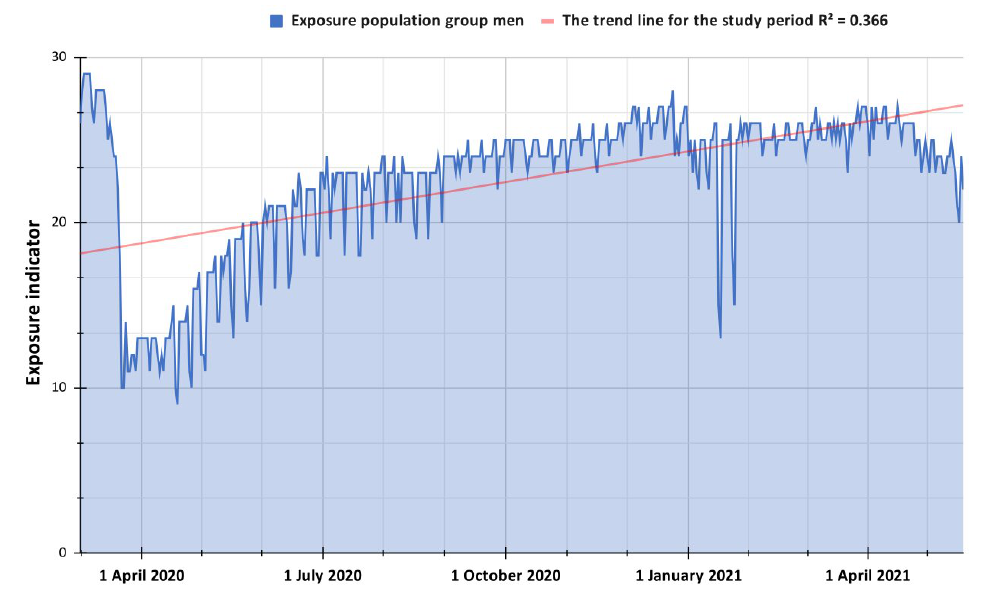
Figure 3. Exposure indicator based on movement ranges (Facebook) for 1 March 2020, to 19 May 2021, in the Popayán